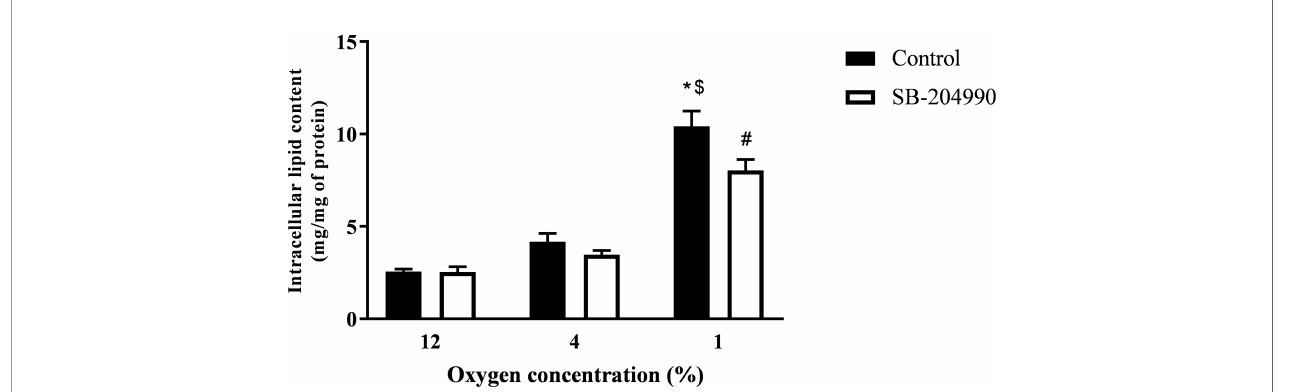
FIGURE 1 | The Effect of Hypoxia and ACLY Inhibitor on Intracellular Lipid Content. The effect of hypoxia and ACLY inhibitor (SB-204990) on lipid accumulation in cells. Differentiated L6 myotubes were exposed to hypoxia for 7 days, subsequently treated with 40 m M SB-204990 for 24 hours and lipid content data compared to respective vehicle-treated (DMSO) cells. N = 6; *p < 0.01 for comparison with control exposures (12% O 2 , 2-way ANOVA); $ p < 0.01 for comparison with 4% O 2 exposures (2-way ANOVA); # p < 0.05 for comparsion with vehicle treated cells (2-way